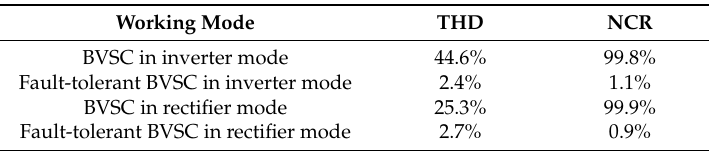
Table 3. Comparison of current THD and unbalance.